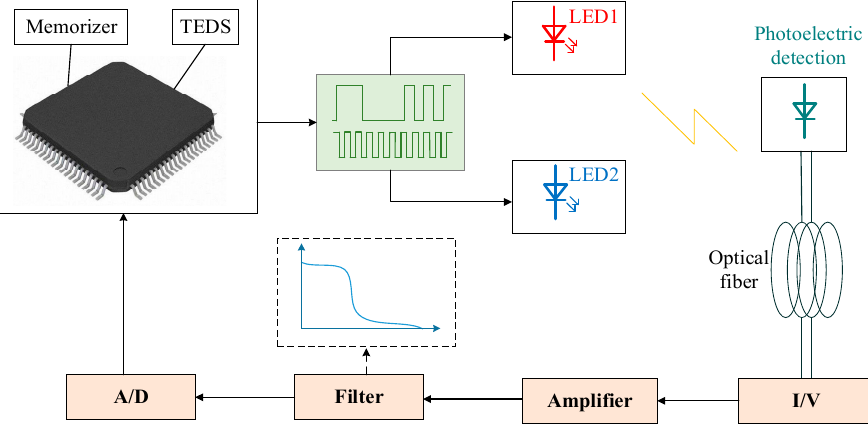
Figure 5. Signal processing module based on the fluorescence lifetime detection principle.